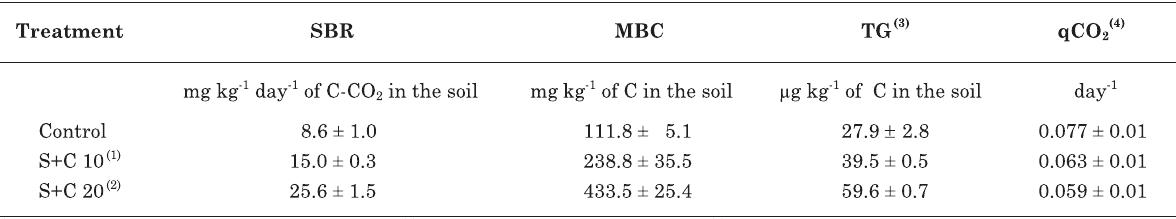
Table 3. Soil basal respiration (SBR), Microbial biomass C (MBC), Soil total glucose (TG) and metabolic quotient (qCO ) in the treatments 2